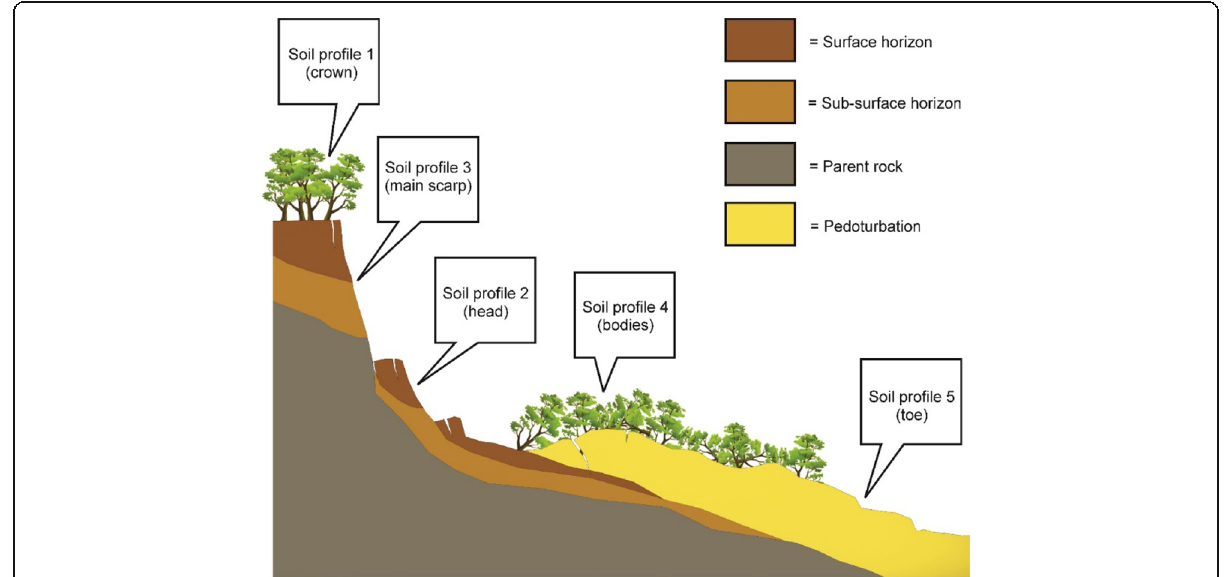
Fig. 3 Illustration of site sampling and design at five landslide parts